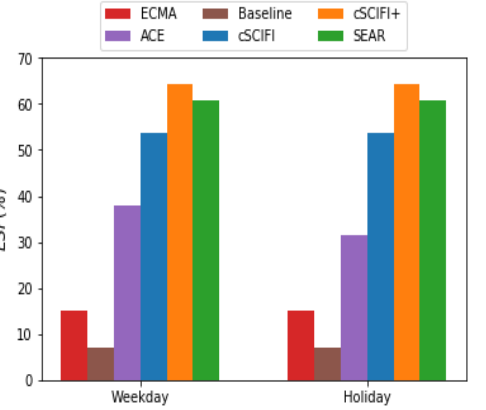
Figure 7. Normalized Energy saving factor comparison between a holiday and a